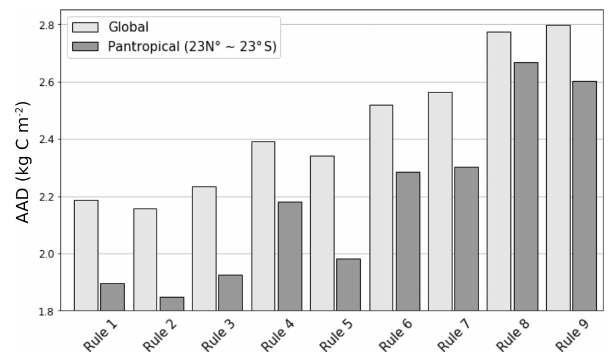
Figure 8. Average of absolute difference in carbon density between estimations of the nine translation rules and two diagnostic maps: global comparison with IPCC Tier-1 biomass density map (incl. above- and belowground); tropical comparison with Baccini’s car- bon density map (only aboveground).